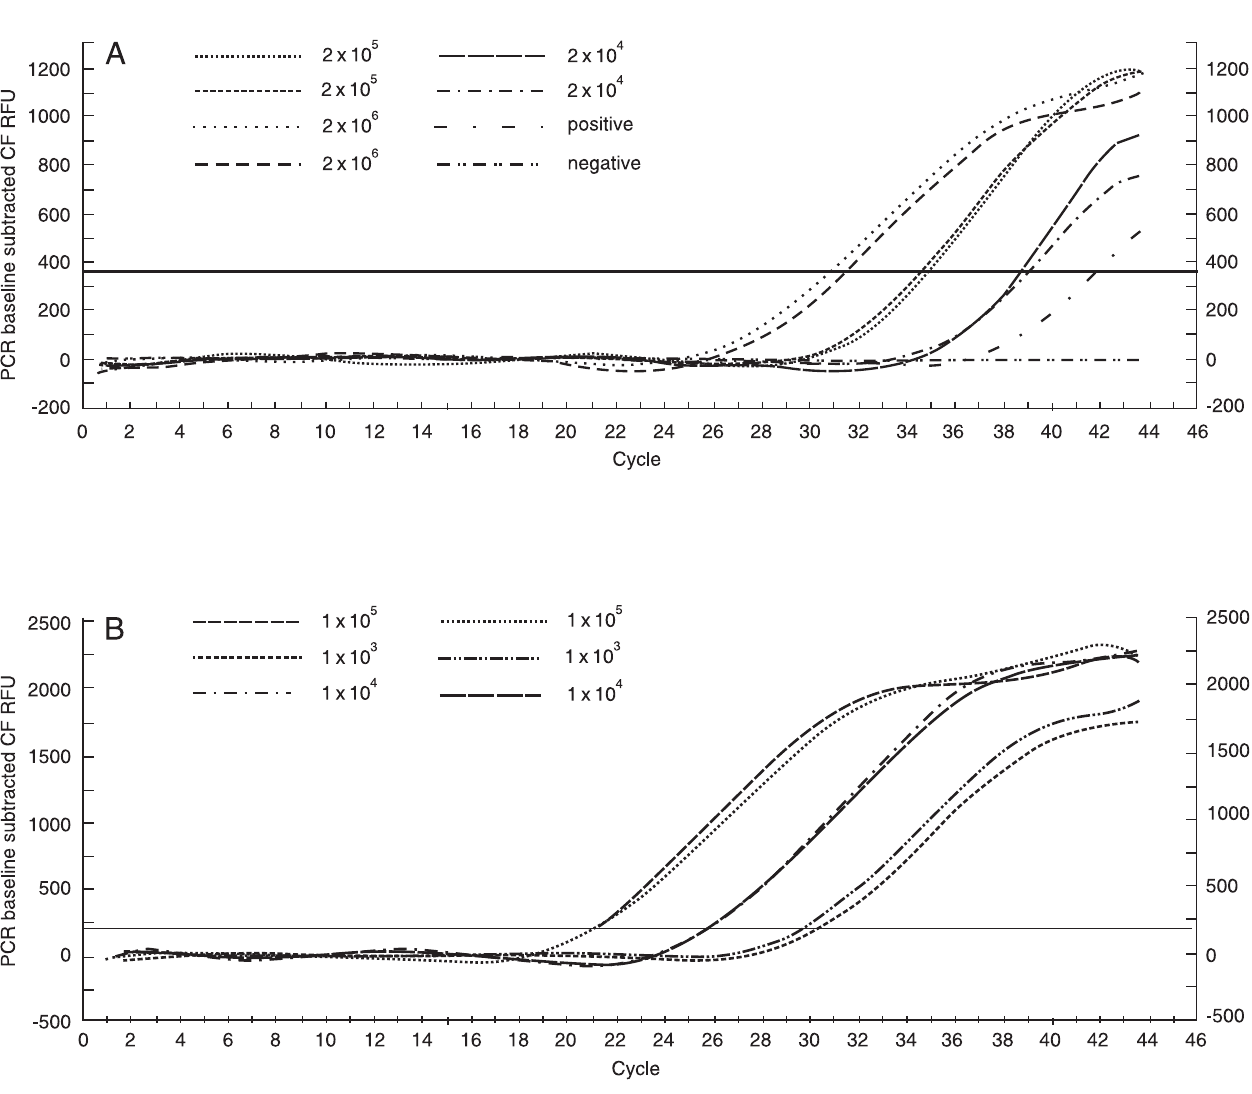
Figure 1. PCR amplification versus cycle for dilutions of DNA control (A) and HTLV-I control using DNA from MT2 cells (B). CF = coefficient; RFU = relative fluorescence